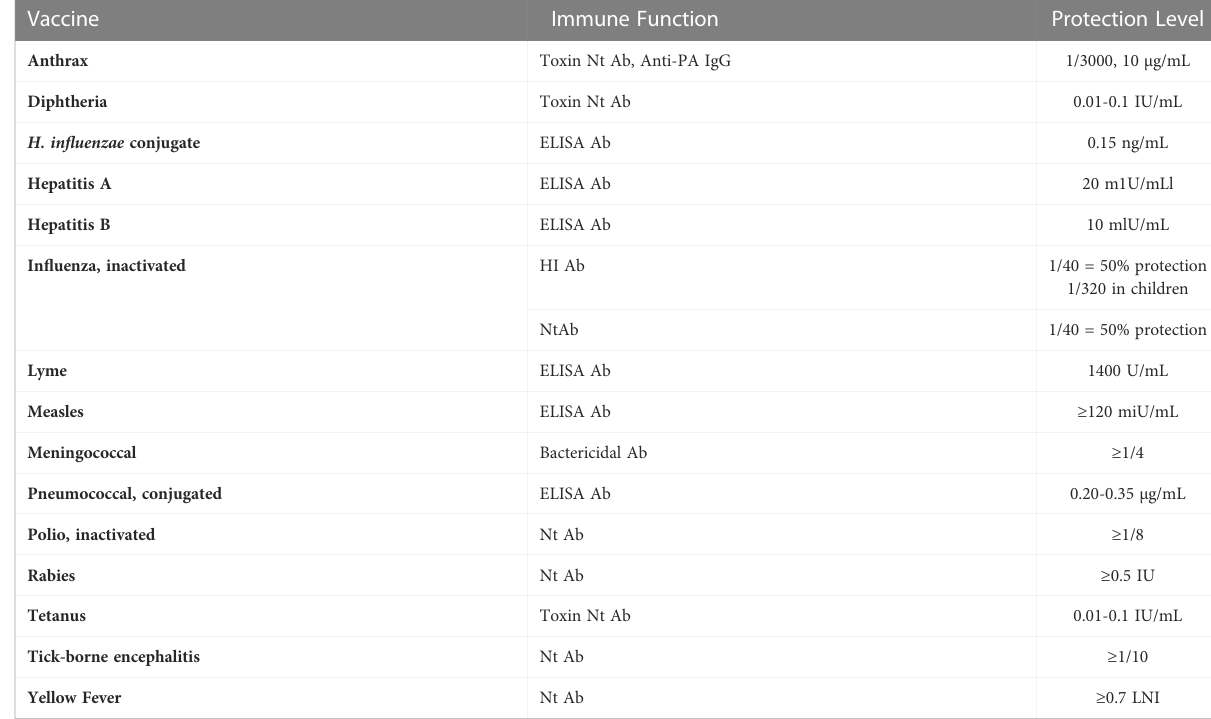
TABLE 1 Selected correlates of protection after vaccination.